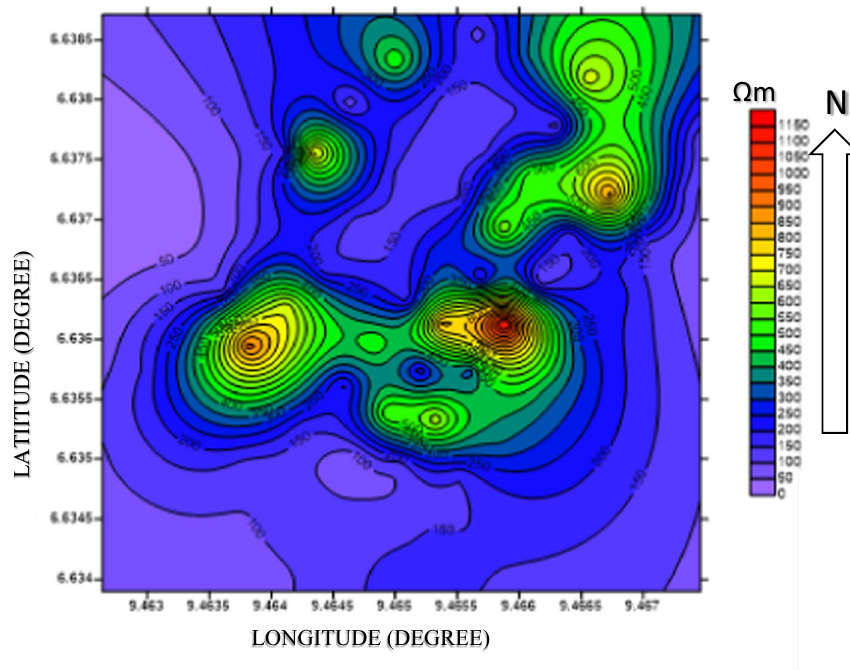
Fig. 4 Iso-resistivity contour map of the second layer